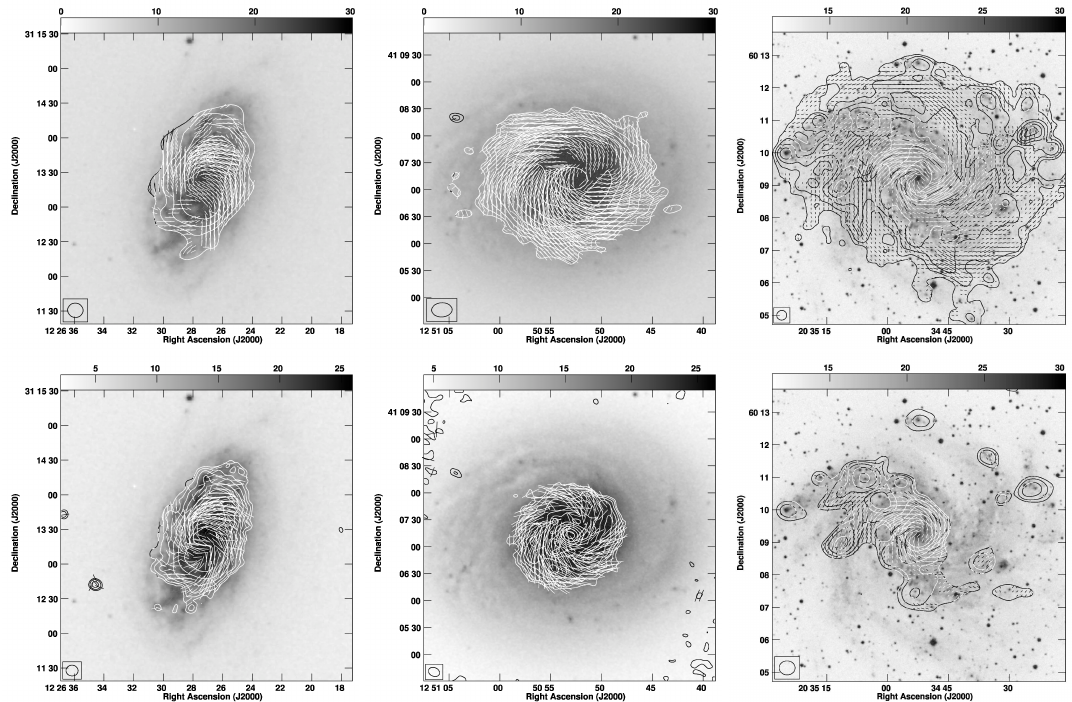
Figure 1. Magnetic-orientation maps superposed on contour plots of Stokes I for NGC 4414 ( left ), NGC 4736 ( middle ), and NGC 6946 ( right ) in the C ( top ) and X ( bottom ) bands. Gray scale and contour images are B-band optical images taken from the Digitized Sky Survey (DSS) and images of Stokes I. Contour levels are 3, 6, 12, 24, 48, and 96 × ∆ I (mJy/beam). Pixel numbers are 1024 for all images, and magnetic-field orientations are plotted every 15